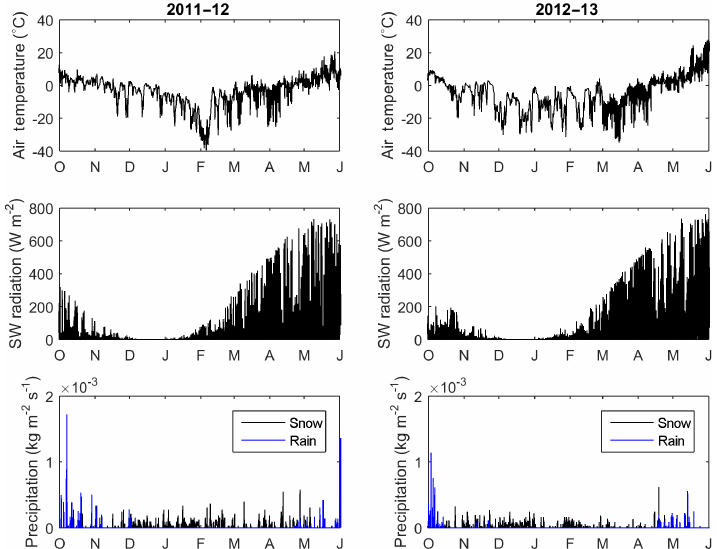
Figure 2. Air temperature, solar radiation, and precipitation data measured at the Sodankylä site, used as inputs for the JIM